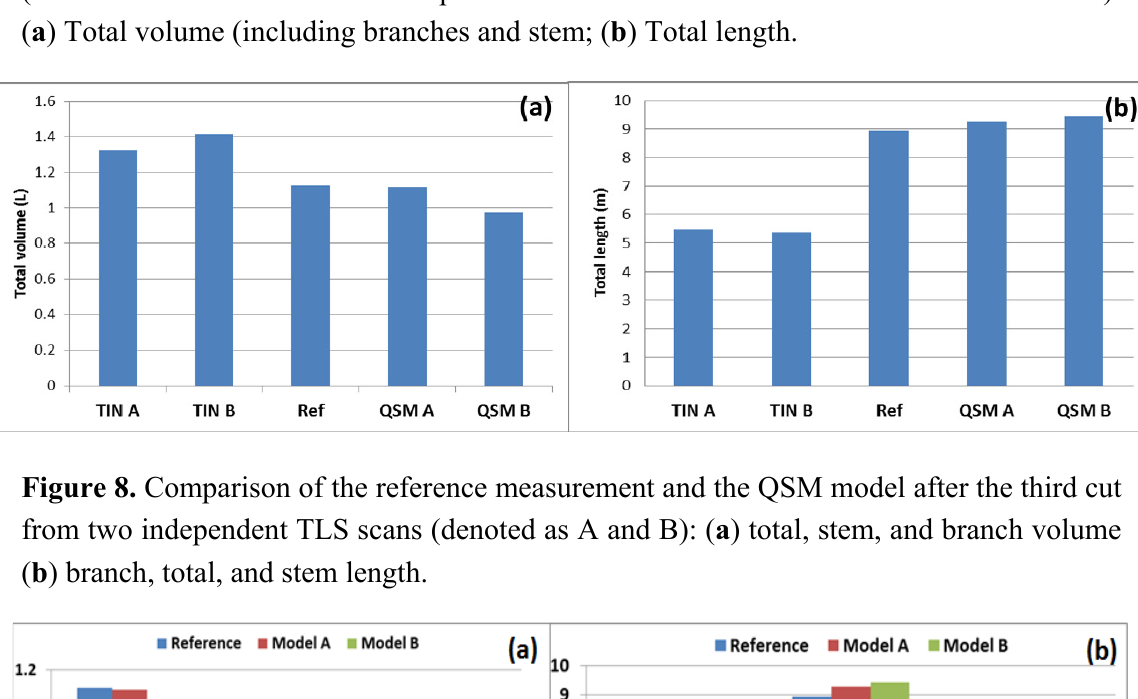
Figure 7. Comparison of the QSM, reference, and the TIN model after the third cut (3A and 3B denote the two independent sets of TLS scans made after the third cut):